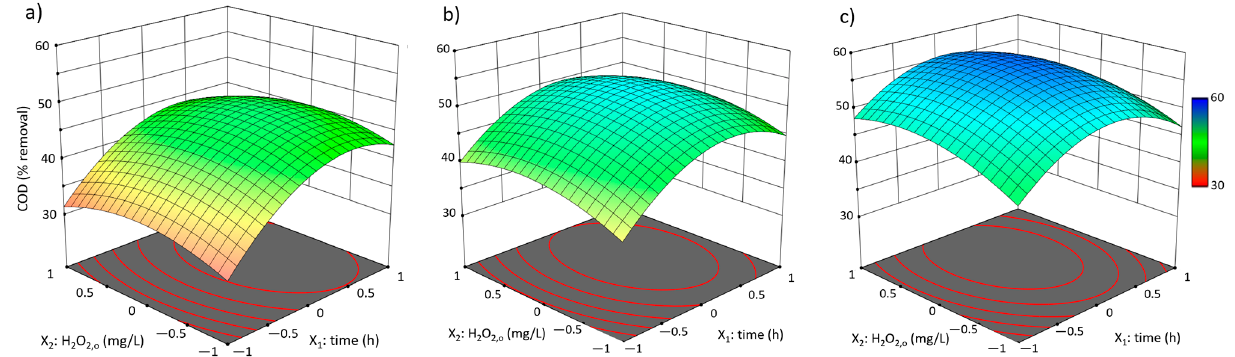
( c ) Figure 3. 3D plots of the cross-factor interaction effects between H 2 O 2,o and reaction time (X 1 X 2 ) on Figure 3. 3D plots of the cross-factor interaction effects between H 2 O 2 and reaction time (X 1 X 2 ) on COD removal (Y 1 ) at Fe o3+ (X 3 ) concentration of ( a ) 75 mg/L; ( b ) 200 mg/L; ( c ) 325 mg/L. COD removal (Y 1 ) at Fe 3+ (X 3 ) concentration of ( a ) 75 mg/L; ( b ) 200 mg/L; ( c ) 325 mg/L.